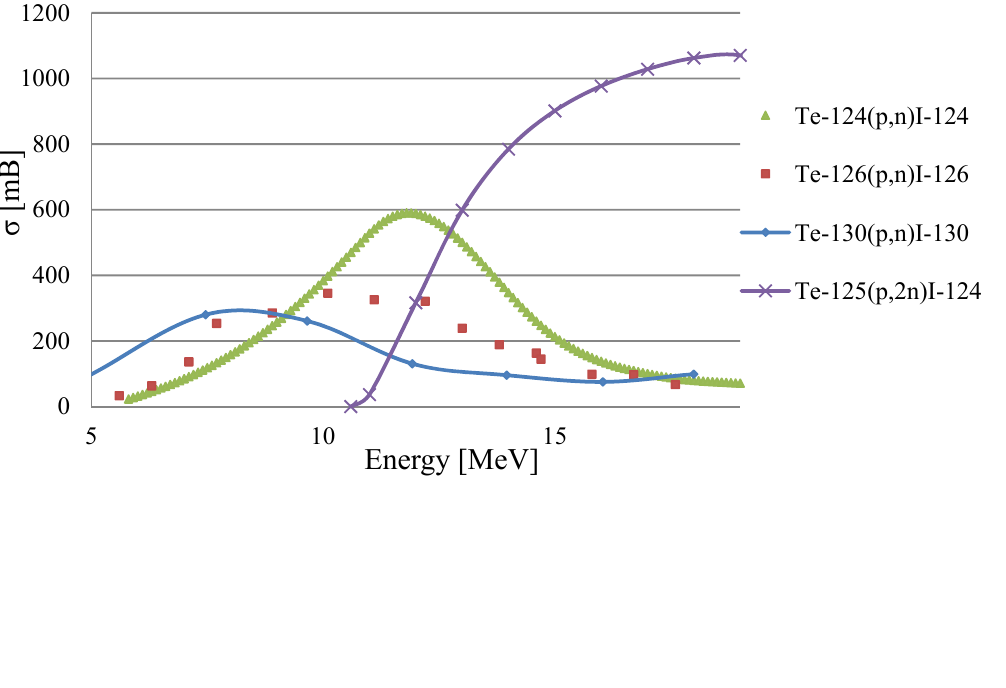
Figure 6. Graph showing the excitation functions of 124 Te(p,n) 124 I [8], 126 Te(p,n) 126 I [11], 130 Te(p,n) 130 I [12] and 125 Te(p,2n) 124 I [13]. As the beam energy is degraded as it